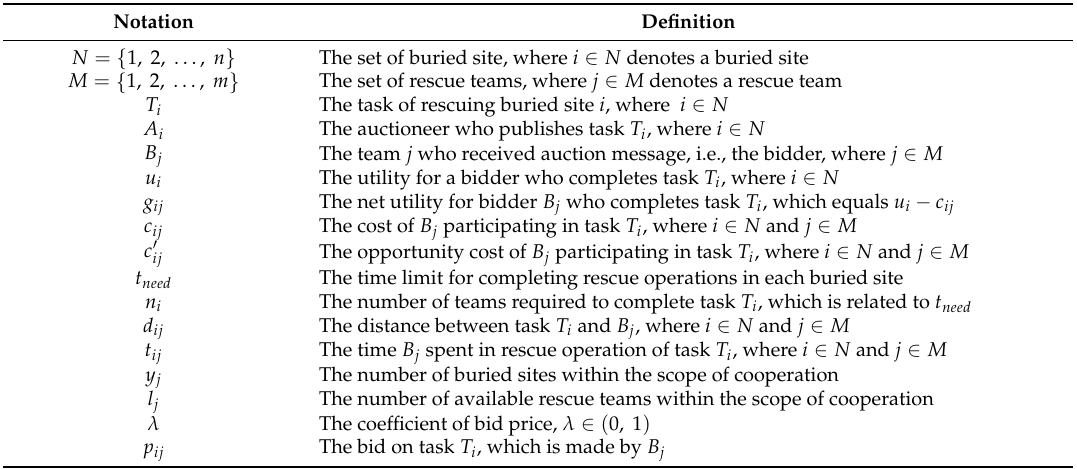
Table 1. Main notations related to the auction-based algorithm.